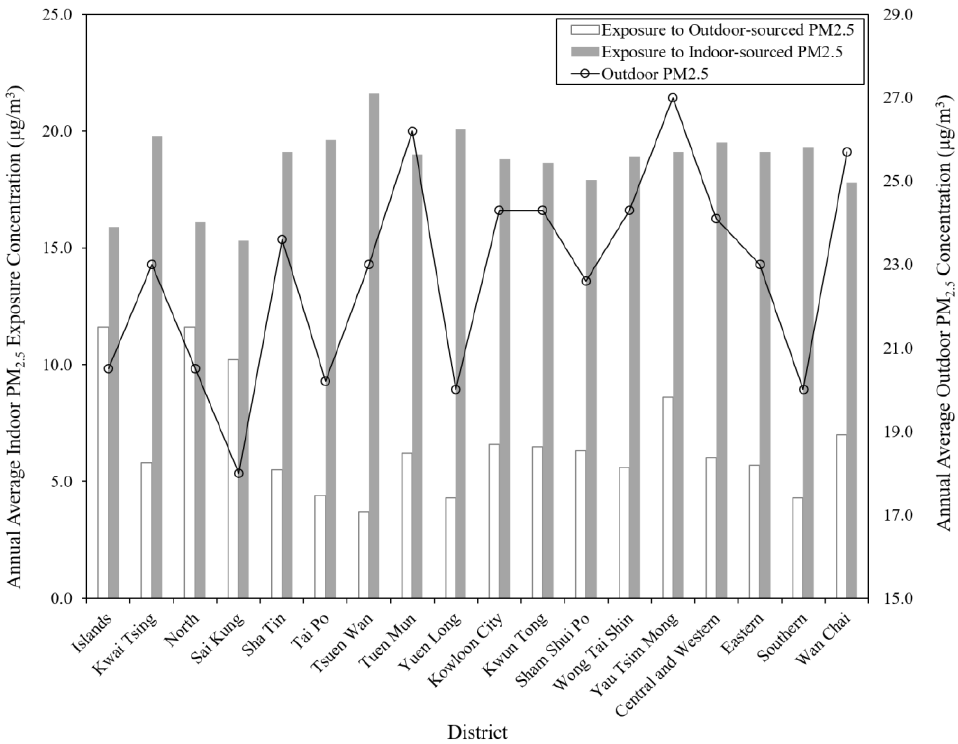
Figure 9. Exposure concentrations to indoor- and outdoor-sourced PM 2.5 for dwellings across Hong Kong, averaged over the pensioner and family results. Kong, averaged over the pensioner and family